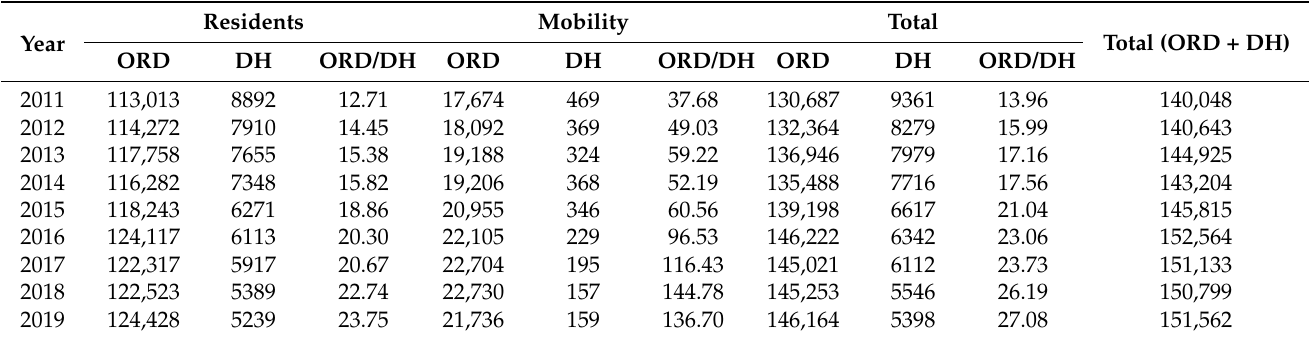
Table 1. Patients’ admission to Italian hospitals for hospital orthopedic intensive rehabilitation,